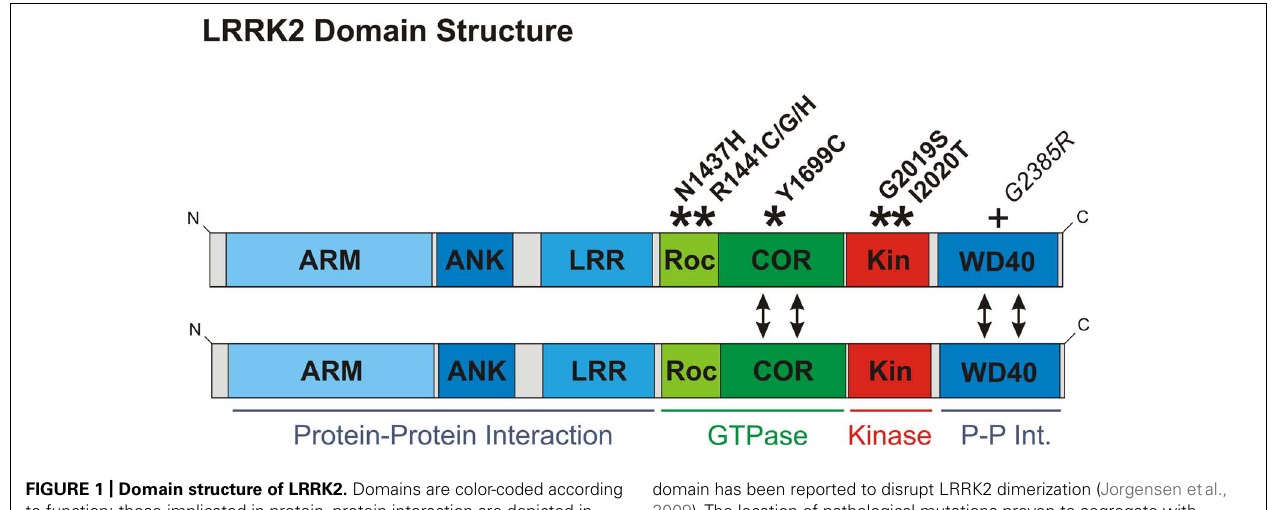
domain has been reported to disrupt LRRK2 dimerization (Jorgensen etal., 2009).The location of pathological mutations proven to segregate with Parkinson’s disease are shown with asterisks and bold font. Although only considered a risk factor, the G2385R mutation is also depicted with a plus sign, since this mutation is mentioned in the main text and is very frequent amongst Asian populations. ARM, armadillo repeat; ANK, ankyrin repeat; LRR, leucine-rich repeat; Roc, ras of complex proteins; COR, c-terminal of Roc; Kin,